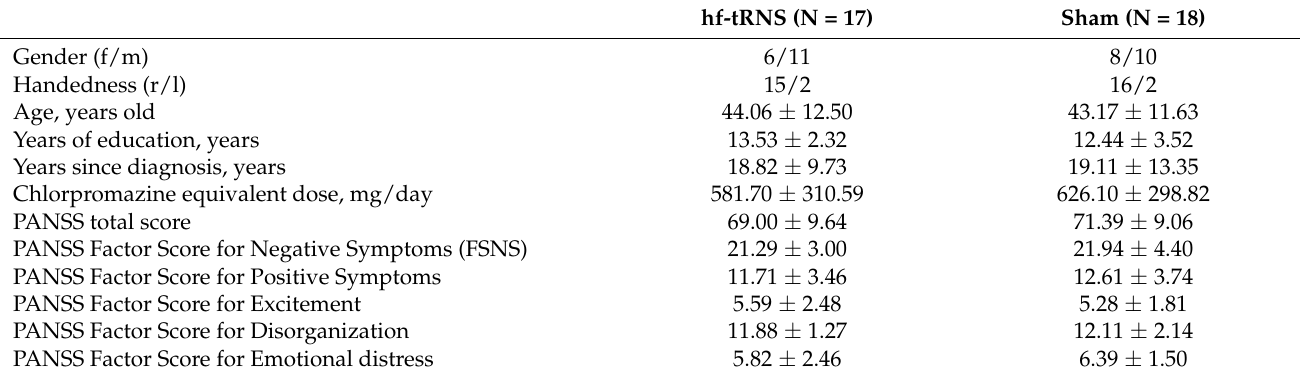
Table 1. Patient demographics and clinical